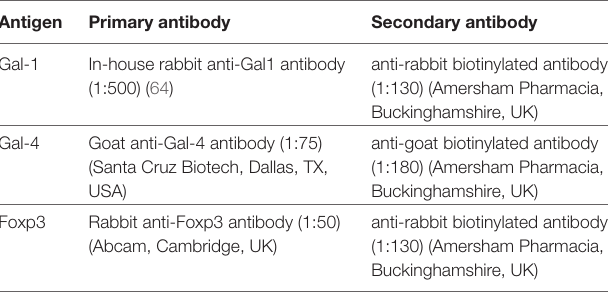
tABLe 2 | Analysis of duodenal biopsies from control subjects, untreated CeD patients, and CeD patients subjected to gluten withdrawal.